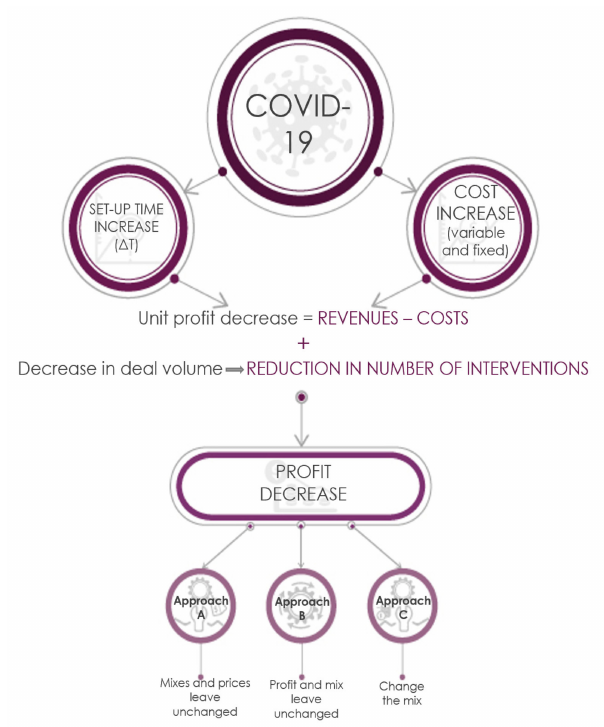
Figure 1. The e ff ect of anti-COVID recommendations on the markup of a dental surgery and three possible approaches for making economic